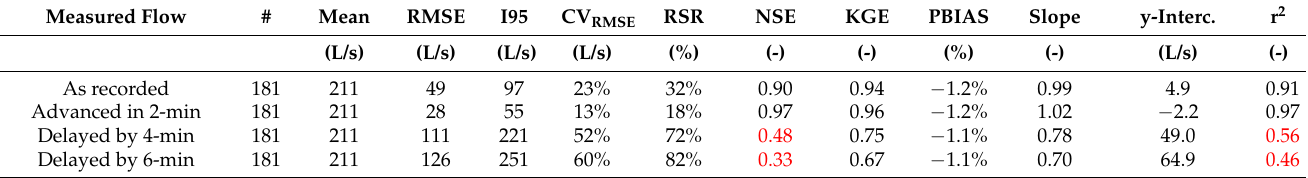
Figure 2. Measured and modelled hydrographs during a rainfall event. Table 1. Statistical results for the four scenarios of synchronization of the time series in Figure 2.